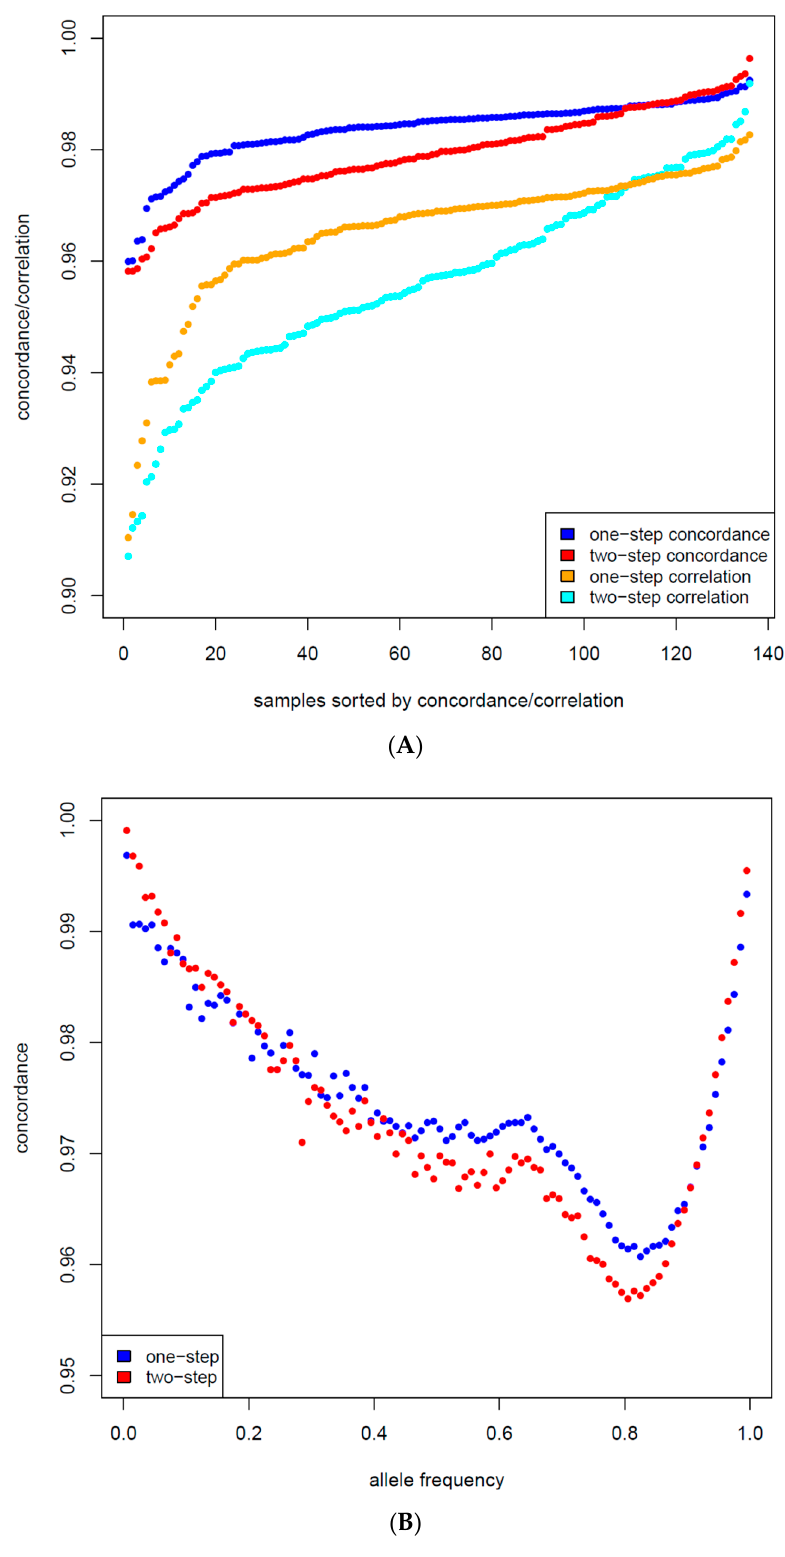
Figure 3. ( A ) Concordance and correlation of samples for one-step and two-step imputation. ( B ) Concordance by bins allele frequency (0.01 interval) for one-step and two-step imputation. Keeping in mind that these were different animals and not the same sample sizes, the At the genotype level, concordances were still high (Table 2) but noticeably lower than discordance between 50K genotypes and sequence was 0.445%, higher than between the the 50K-700K imputation (Table 1). The error rates of the heterozygotes were 5.15%